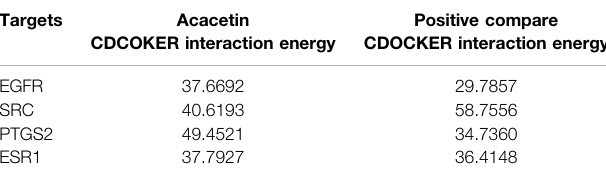
TABLE 1 | Interaction of acacetin and hub targets by discovery studio